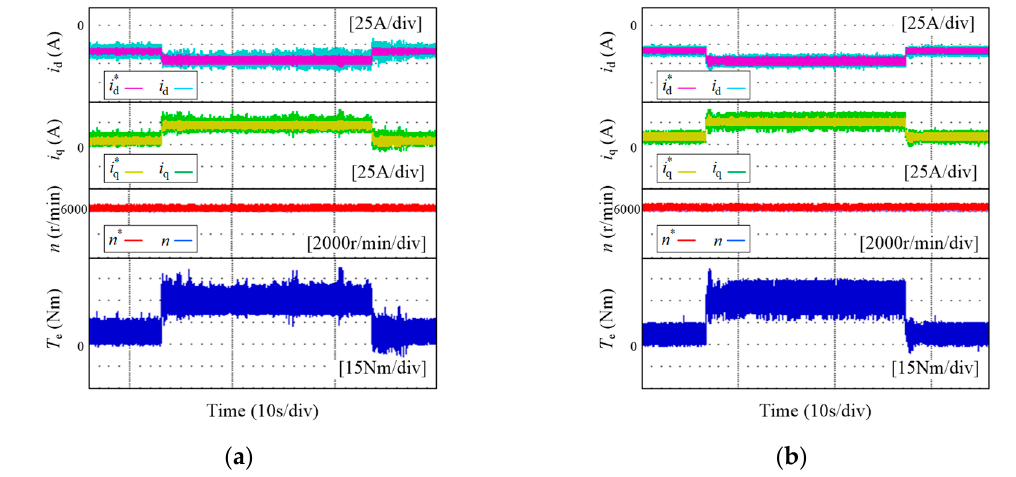
Figure 12. The loading and unloading waveforms in the flux-weakening region: ( a ) The traditional control strategy-based PI controller; ( b ) The improved UDE-based control strategy.